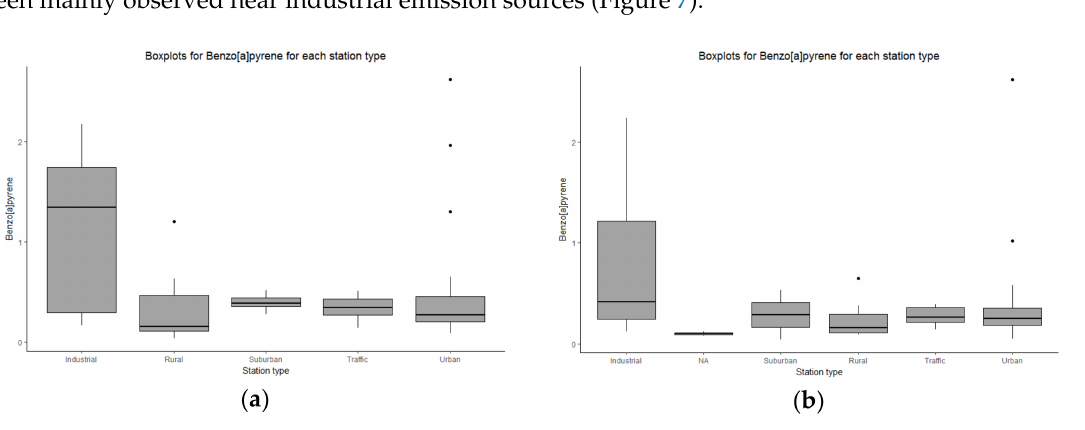
Figure 7. Measured concentrations of the B[a]P (ng/m 3 ), by station type, for ( a ) 2010 and ( b )